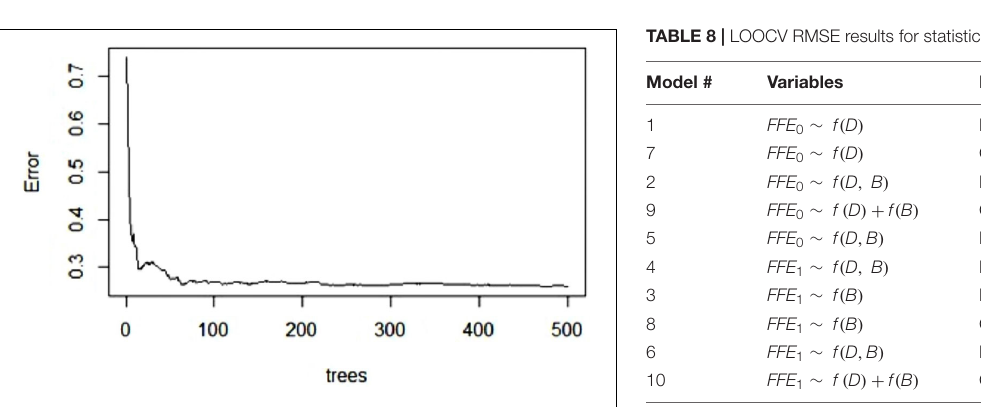
FIGURE 3 | Random forest OOB error, based on the number of trees.